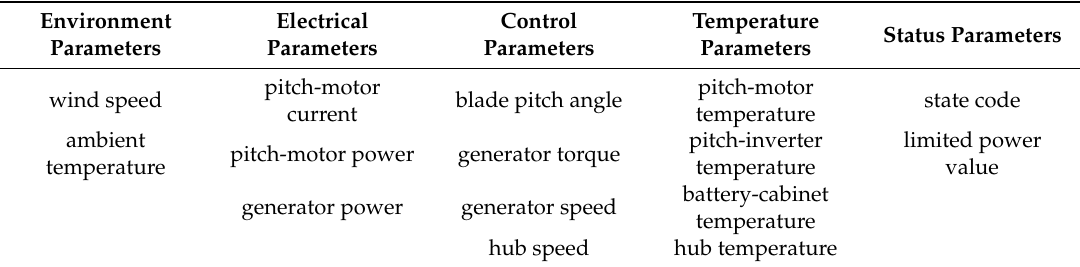
Table 1. The initial parameters related to the pitch